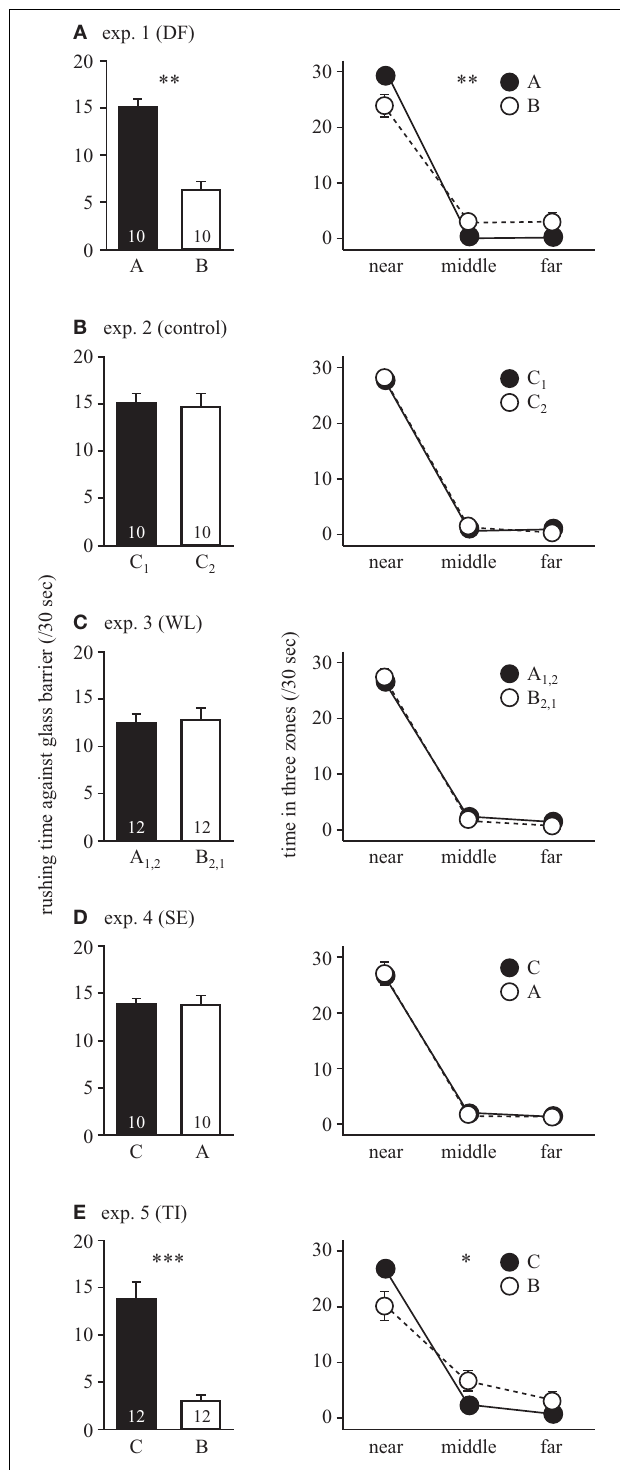
FIGURE 3 | Results of five experiments testing different hypotheses of cognitive abilities. Right and left panels show the rushing time against glass barrier per 30s and the time in three (near, middle, and far) zones per 30s, respectively. (A) Experiment 1 testing whether direct interactions affect the